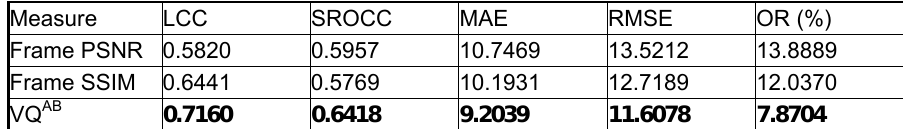
Table 6 – Linear correlation coefficient (LCC) between subjective and objective quality scores (after nonlinear regression) on the CSIQ Video subsets